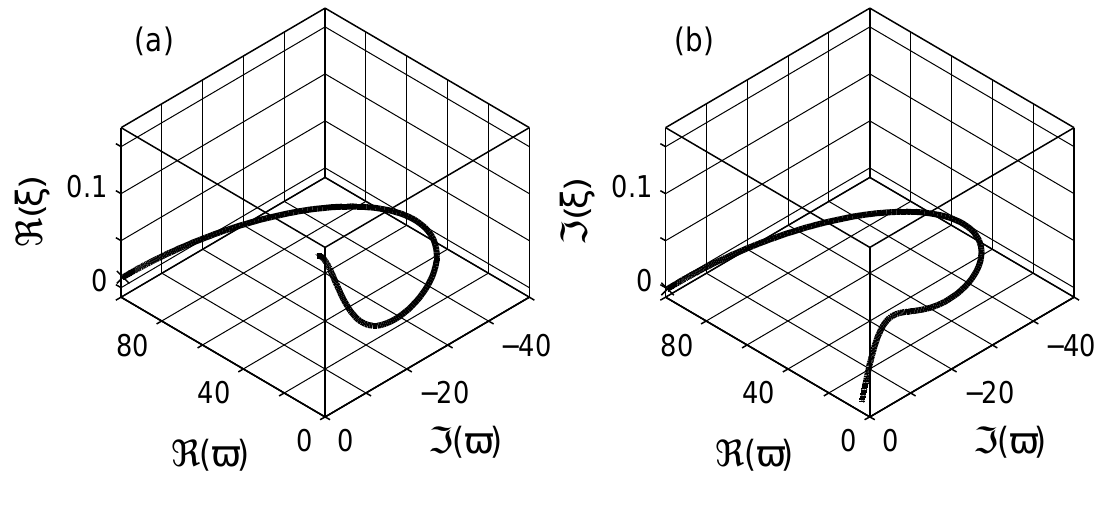
Figure 5 . Three-dimensional line plots of (a) the real (cid:60) ( ξ ) and (b) the imaginary (cid:61) ( ξ ) parts of the “scaled” permittivity for a Maxwell Garnett mixture. The inclusions are spherical d = 3 , and q = 0 . 3